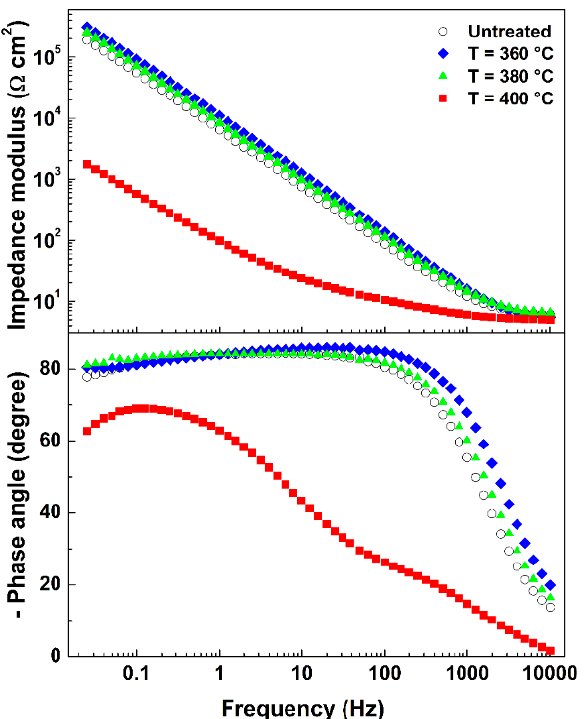
Figure 9. Bode plots of samples untreated, nitrided for 3 h, at 360 and 380 ◦ C, using 50 vol.% N 2 + 50 vol.% H 2 , and at 400 ◦ C, using 80 vol.% N 2 + 20 vol.% H 2 . Representative EIS spectra of samples nitrided at 360 ◦ C for different durations and at 380 ◦ C with different nitrogen content in the treatment atmosphere are shown in Figure